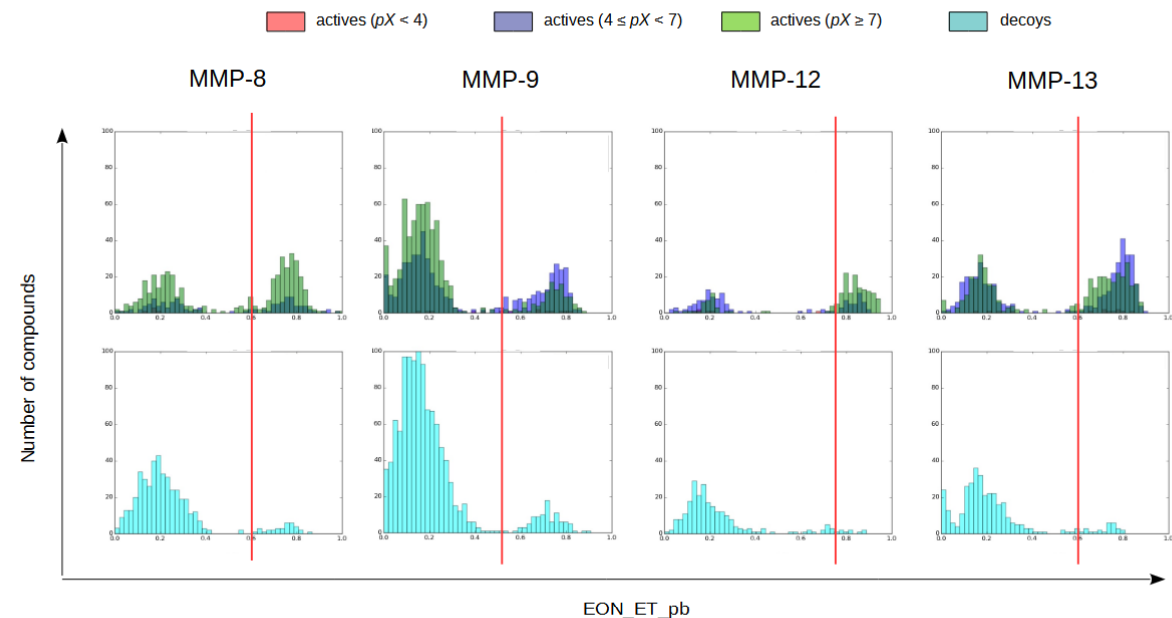
Figure 1. Histogram representations of the highest electrostatic Tanimoto (i.e., EON_ET_pb) values obtained in the comparison of the validation set with all queries. For each MMP, two histograms are shown: one for actives and one for decoys. In the actives histogram, actives with a pX lower than 4 are in red, actives with a pX between 4 and 7 are in blue and actives with a pX higher than 7 are in green. In the decoys histogram, decoys are in cyan. The EON_ET_pb cutoff is represented as a red